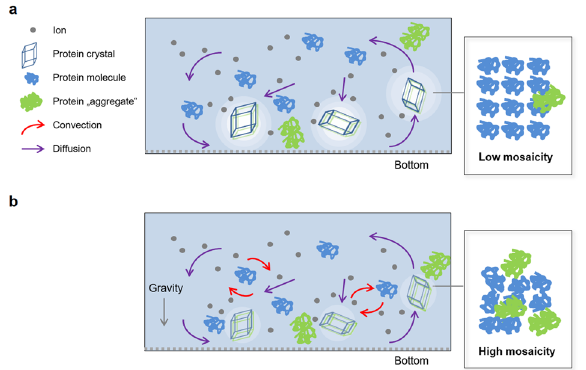
Fig. 1 Scheme showing comparative mass transport. under microgravity and 1 G. a Under microgravity conditions, b on earth and resulting effects on protein crystal quality/mosaicity are shown. Particularly, the formation of spherical protein and protein aggregate depletion zones under microgravity conditions is supposed to be facilitated by the suppression of convection 48 . npj Microgravity (2022)